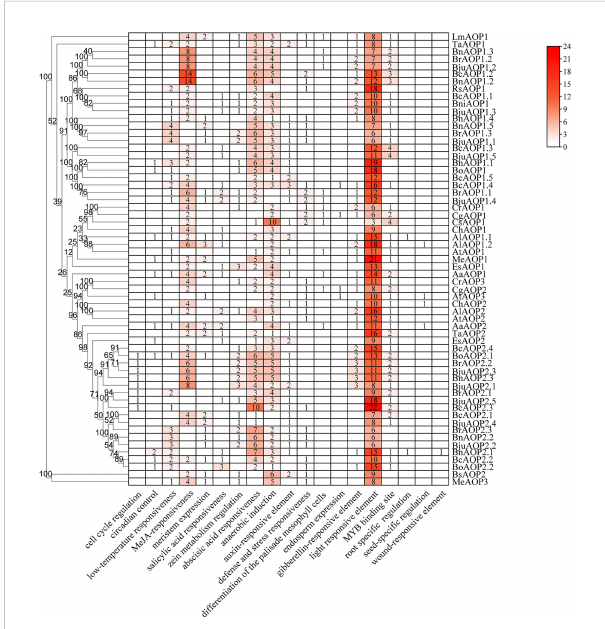
FIGURE 4 Cis-acting regulatory elements in the promoter region of AOP genes. The numbers and the depth of red represent the frequency of the elements that occur in the promoter region.